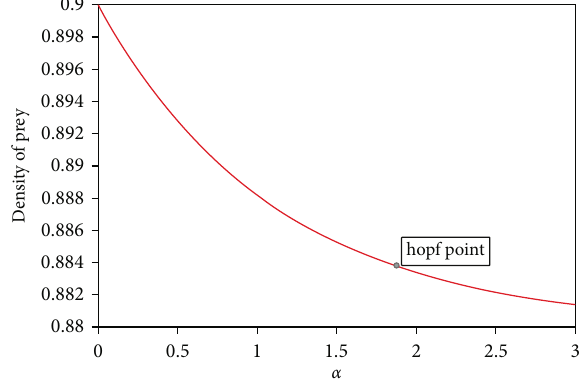
Figure 16: Hopf bifurcation diagram of system (4) around the coexistence equilibrium point E 2 for the data set in Table 2 except c 1 = 0 : 12 c 2 = 0 : 05, and β = 0 : 2